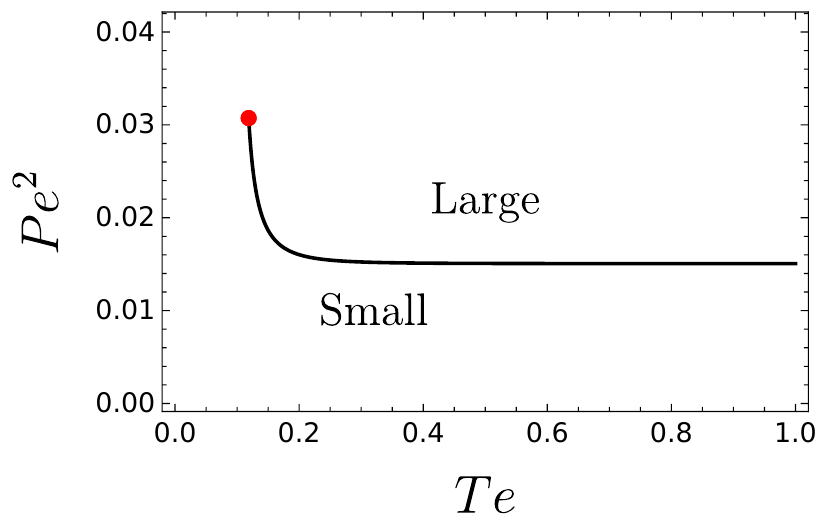
Figure 6 . Phase diagram in four dimensions . The solid black line is the coexistence curve of a (cid:12)rst order phase transition, and the red dot corresponds to the critical point. This plot was constructed for the particular choices, (cid:13) 3 = 0, (cid:13) 4 (cid:25) (cid:0) 9 : 43, (cid:13) 5 (cid:25) 2 : 18 and (cid:13) n = 0 for n > 5. The diagram is qualitatively similar for all valid choices of the parameters. Here, the dimensionful quantities were expressed in terms of the electric charge, which was then set to